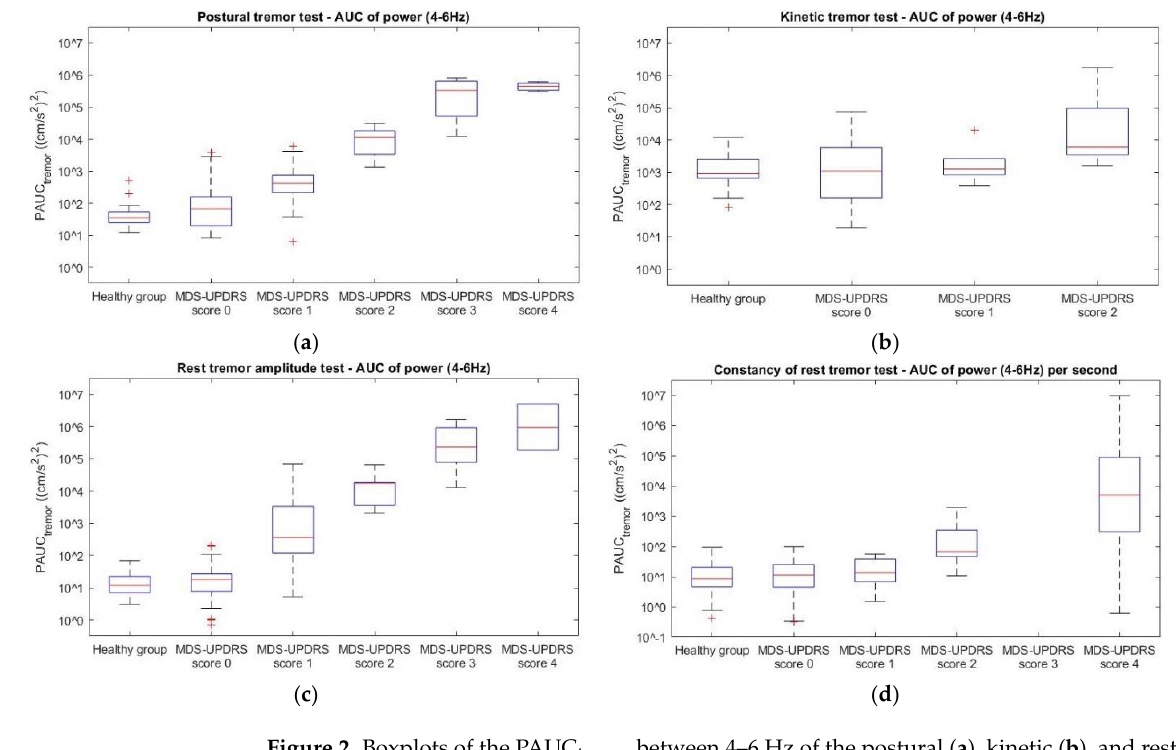
Figure 2. Boxplots of the PAUC tremor between 4 – 6 Hz of the postural ( a ), kinetic ( b ), and rest tremor ( c ) tests in the healthy group and the patient population (per MDS-UPDRS score). The PAUC tremor between 4 – 6 Hz per second of the rest tremor test in all groups is given in boxplot ( d ).